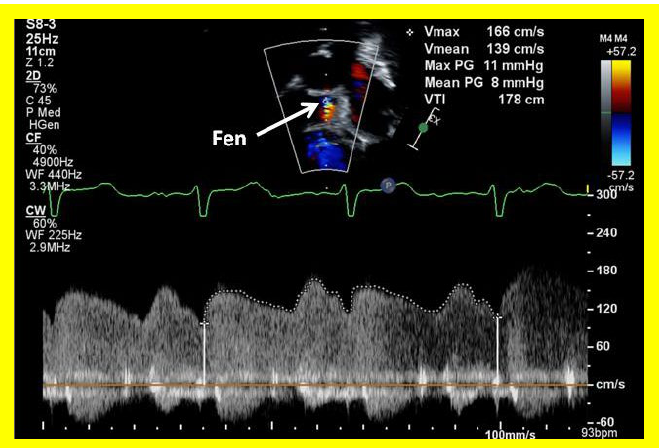
Figure 53. Selected video frame with Doppler sampling across the fenestration (Fen) demonstrating a mean gradient of 8 mmHg.